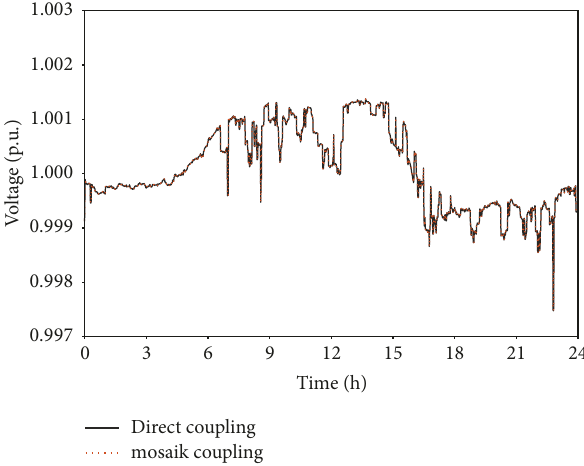
Figure 8: Comparison of simulation results of power system and market with and reference case without cosimulation environment.